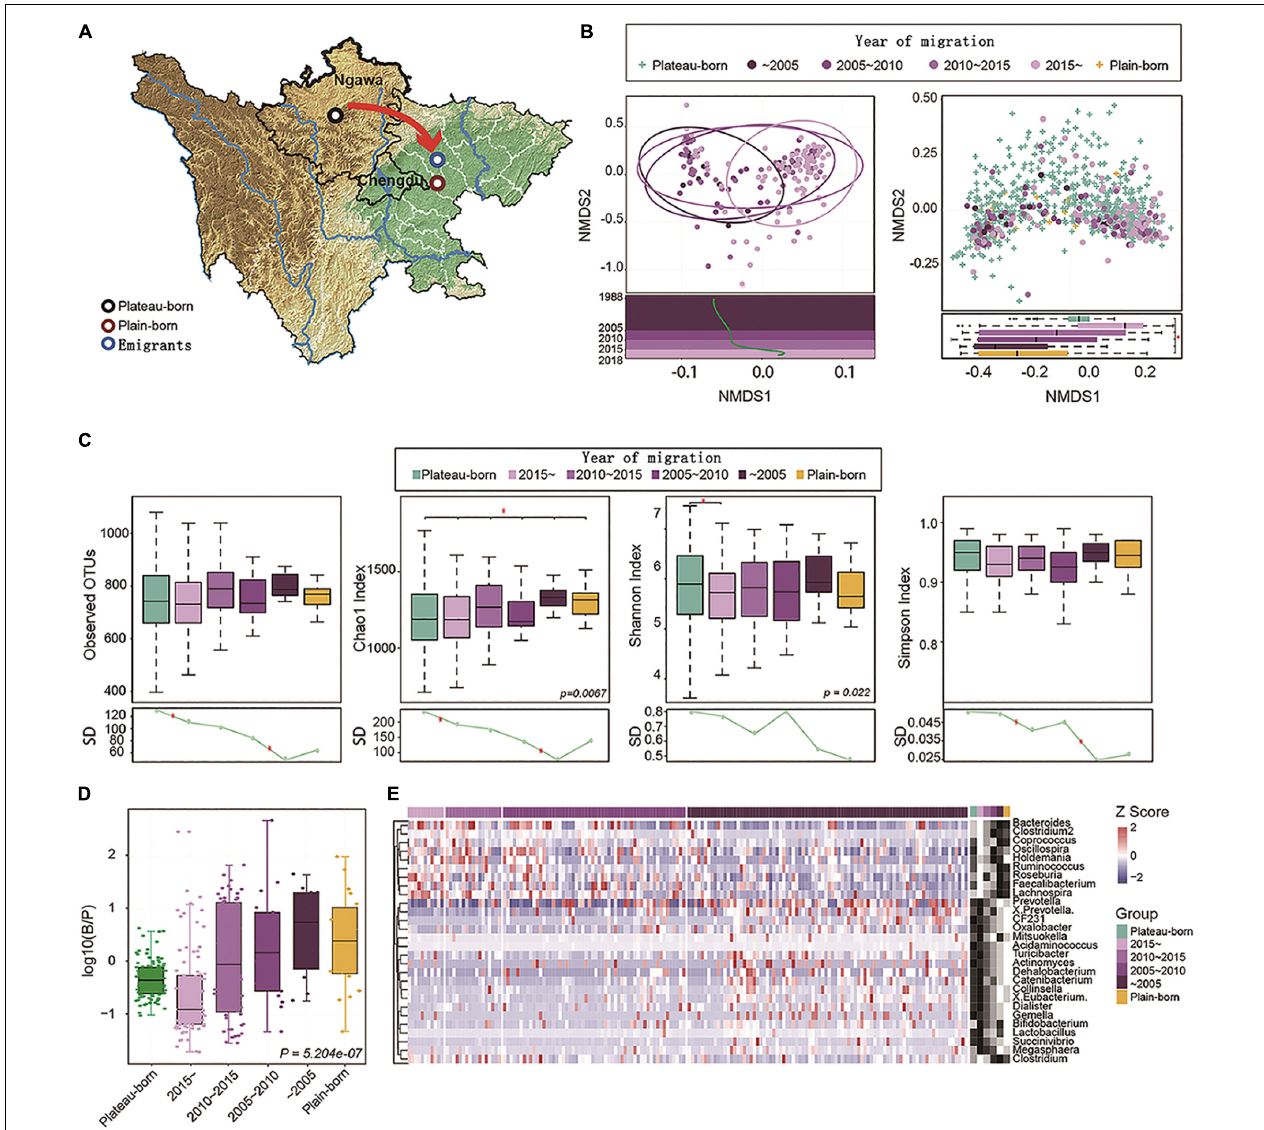
FIGURE 2 | Altitude migration leads to gut microbiome succession in the Tibetan population. (A) Plateau-born ( n = 586), plain-born ( n = 20), and emigrants (Plateau to Plain, n = 170) are marked on the graphics. (B) Left: NMDS plot based on the genus profile from 170 plateau to Plain individuals; each dot represents one individual and the color associated with the year of migration. Linear fitting is based on the first NMDS dimension ( t = 4.94, P = 1.85e-06). Right: Plateau (plateau-born) and Plains (plain-born) individuals were analyzed by NMDS, and the difference between groups in the first dimension is also visualized by a boxplot ( P = 1.589e-11), the NMDS1 values for Plateau-born individuals were the averages of 50 samples by random sampling (100 times). (C) Alpha diversity (observed OTUs, Chao1 index, Shannon index, and Simpson index) between Plateau-born, plain-born, and Plateau to Plain individuals, P -values are from the Kruskal–Wallis test. The standard deviation (SD) in different groups revealed convergence in variance from the plateau to the plain, * P < 0.05. (D) Distribution of the log-normalized Bacteroides -to- Prevotella (B/P) ratio between different groups, P -values are based on Kruskal–Wallis test. (E) Relative abundance of genera correlated with the year of migration (Spearman’s correlation, adjusted P < 0.05); the abundance profiles are transformed into Z -scores, where negative a Z -score means a lower abundance than the mean and a positive Z -score represents a higher abundance than the mean. The red arrows indicates the direction of